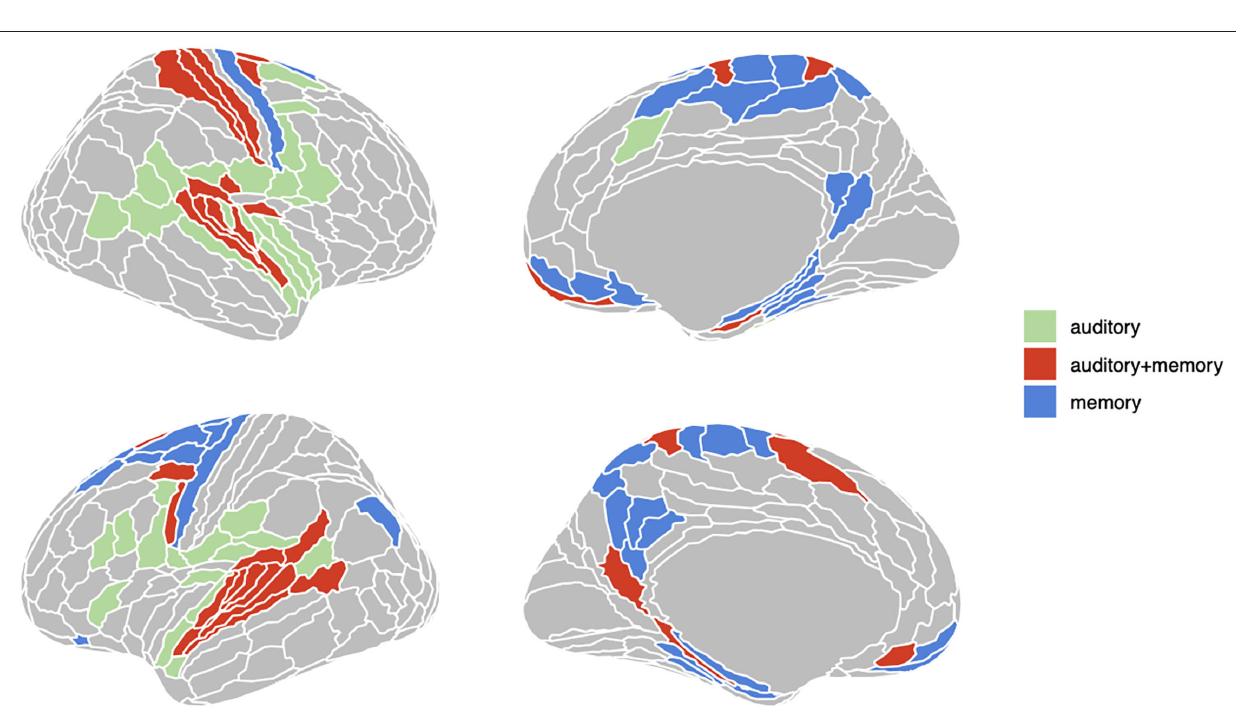
FIGURE 2 | Three groups of ROIs based on univariate analysis. Regions in green are active (FDR < .05) only during encoding phase; regions in red are active both during encoding and delay period; regions in red are only active during delay